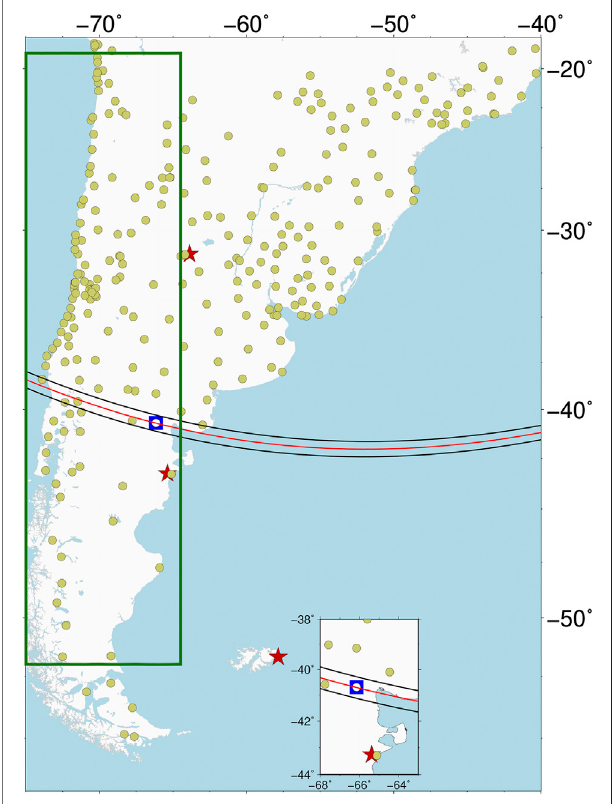
FIGURE 1 | GNSS permanent stations (green circles) and geomagnetic observatories (red stars, namely PIL, TRW and PST from north to south), GNSS station and magnetometers installed in Valcheta, Río Negro (white circleand blue square). Thered and blacklines correspondtothecenter and the limits of eclipse totality path, respectively. Green box identi fi es the region used for latitude behavior analysis, which is shown in Section